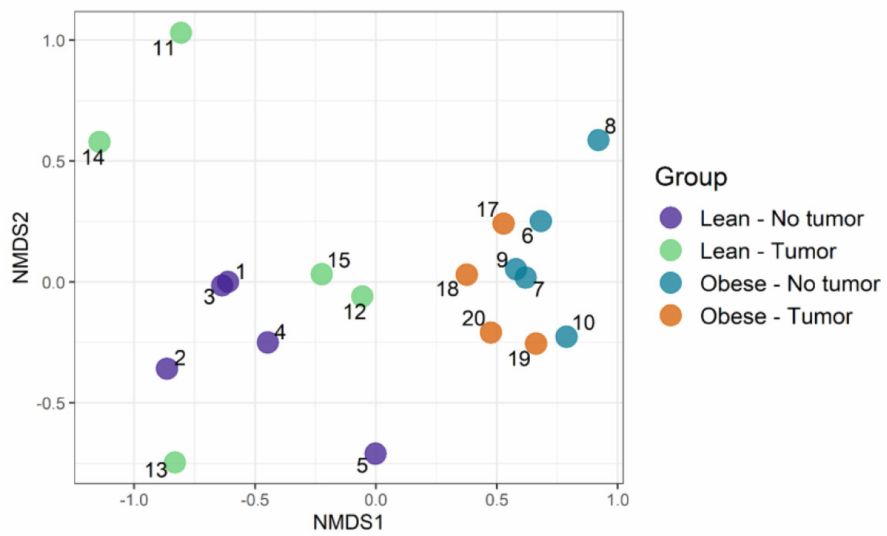
Figure 4. Community composition: visualizing similarity among microbiomes using an ordina- tion